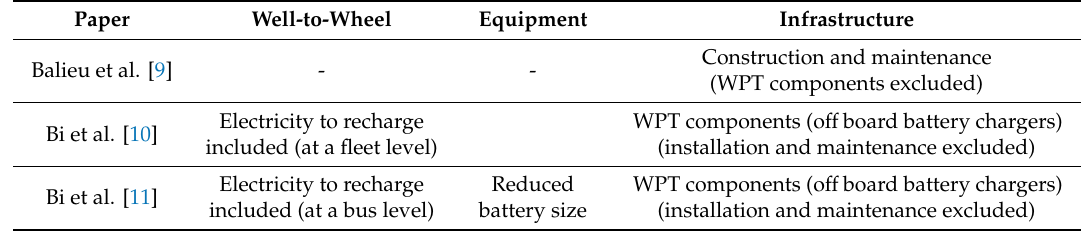
Table 1. The papers that have conducted LCAs of dynamic wireless power transfer technology (DWPT)